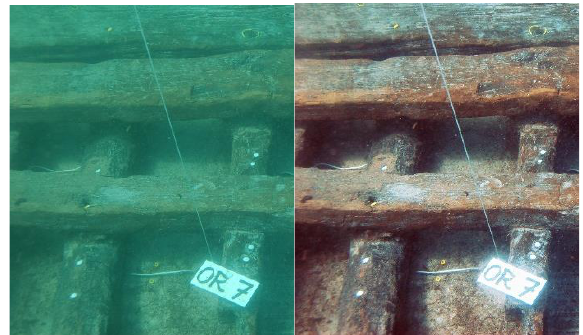
Figure 13 . On the left, an image of the 2007 dataset before the radiometric correction; on the right, the same image after applying the ACE filter.